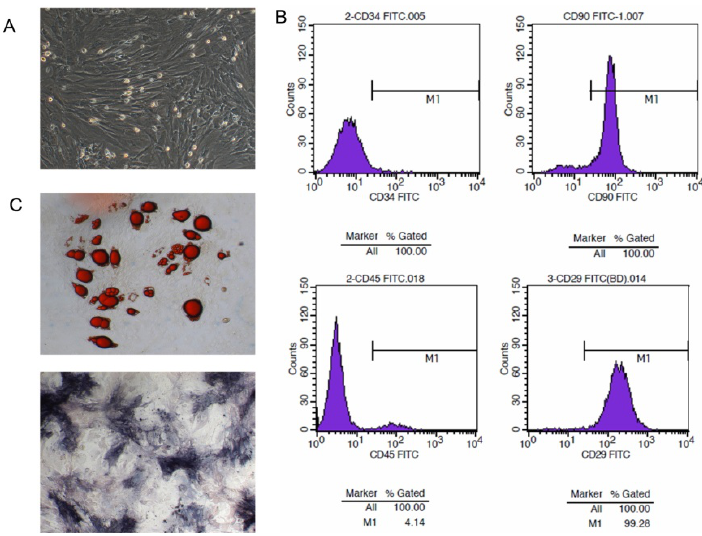
Figure 1. Morphology and characteristics of bone marrow-derived MSCs. ( A ) MSC development and morphology was observed with Olympus microscopy (Olympus Corporation, Tokyo, Japan); ( B ) Immunophenotypic profile of MSCs. Flow cytometric histograms indicated the positive expression of CD29, CD90, while cells were negative for CD34 and CD45; ( C ) Adipogenic and osteogenic differentiation abilities of MSCs. Lipid droplets were visualized by staining with Oil Red O solution. Alkaline phosphatase granules located in the cytoplasm stained intensively with a darker color than the